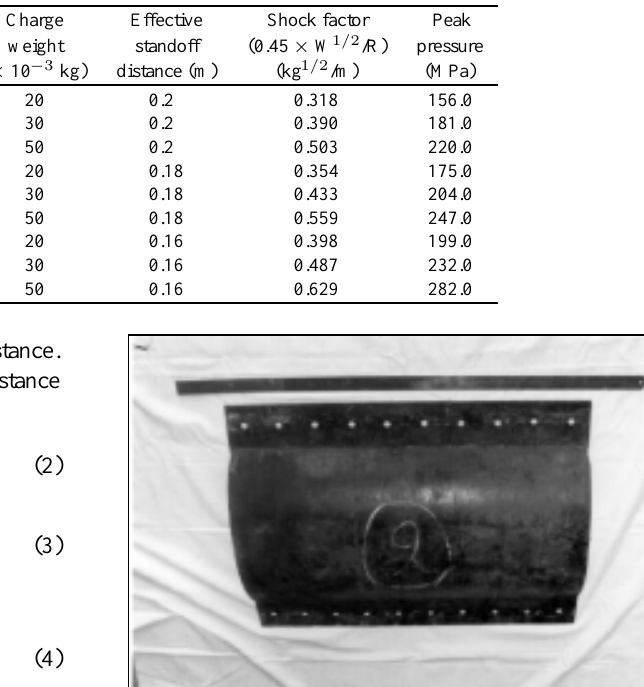
Table 1 Maximum shock pressure at the center of the plate (standoff distance = 0 . 2 m)